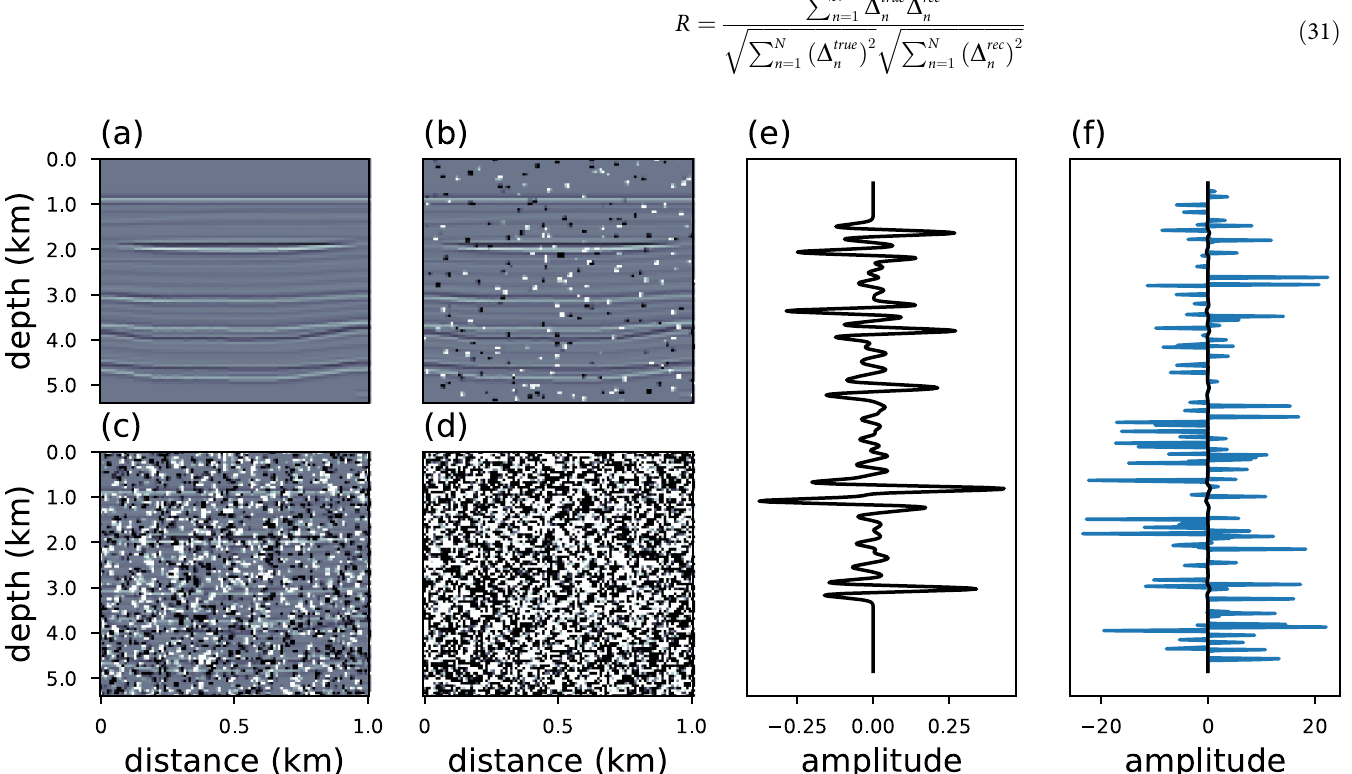
Fig 11. The noiseless seismic data in (a). The same data contaminated with white-noise (signal-to-noise ratio SNR = 80) and spike noise with (b) 0.5%, (c) 5%, and (d) 80%. The black line in panels (e) represents a single seismic trace from the middle of panel (a). The same trace contaminated by noise is represented in (f) spikes (25%).